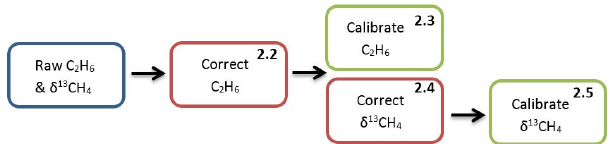
Figure 1. Flow chart illustrating the steps involved to calibrate C 2 H 6 and δ 13 CH 4 . The number in the top right-hand corner cor- responds to the subsection in which the methods of each step are explained in detail.